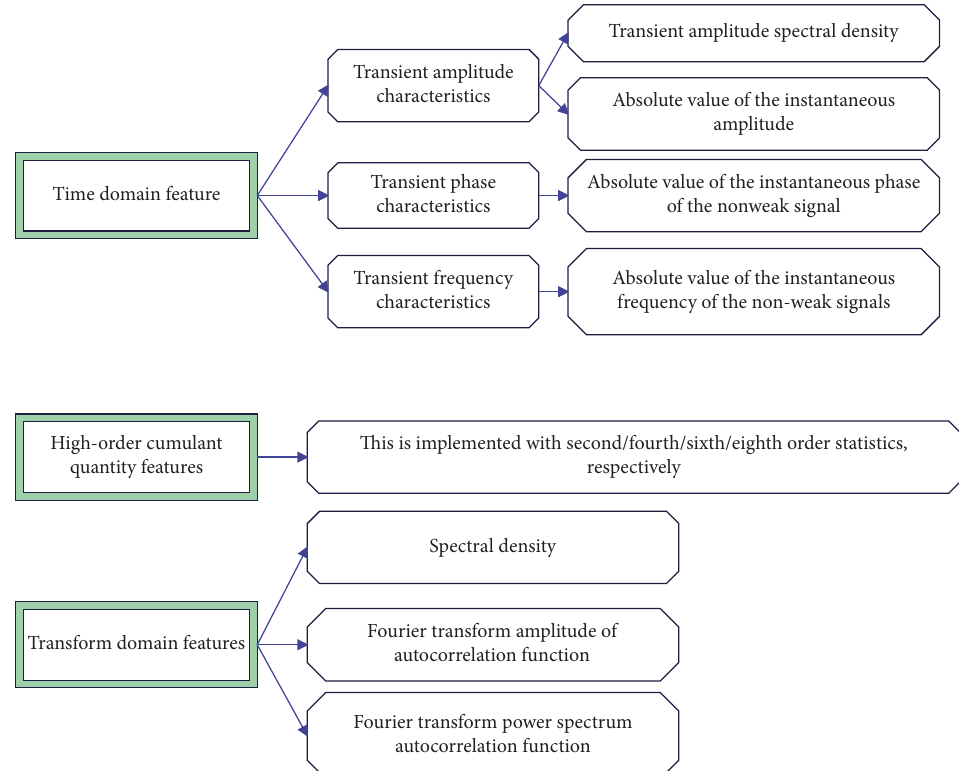
Figure 1: Feature parameters of social network crisis data